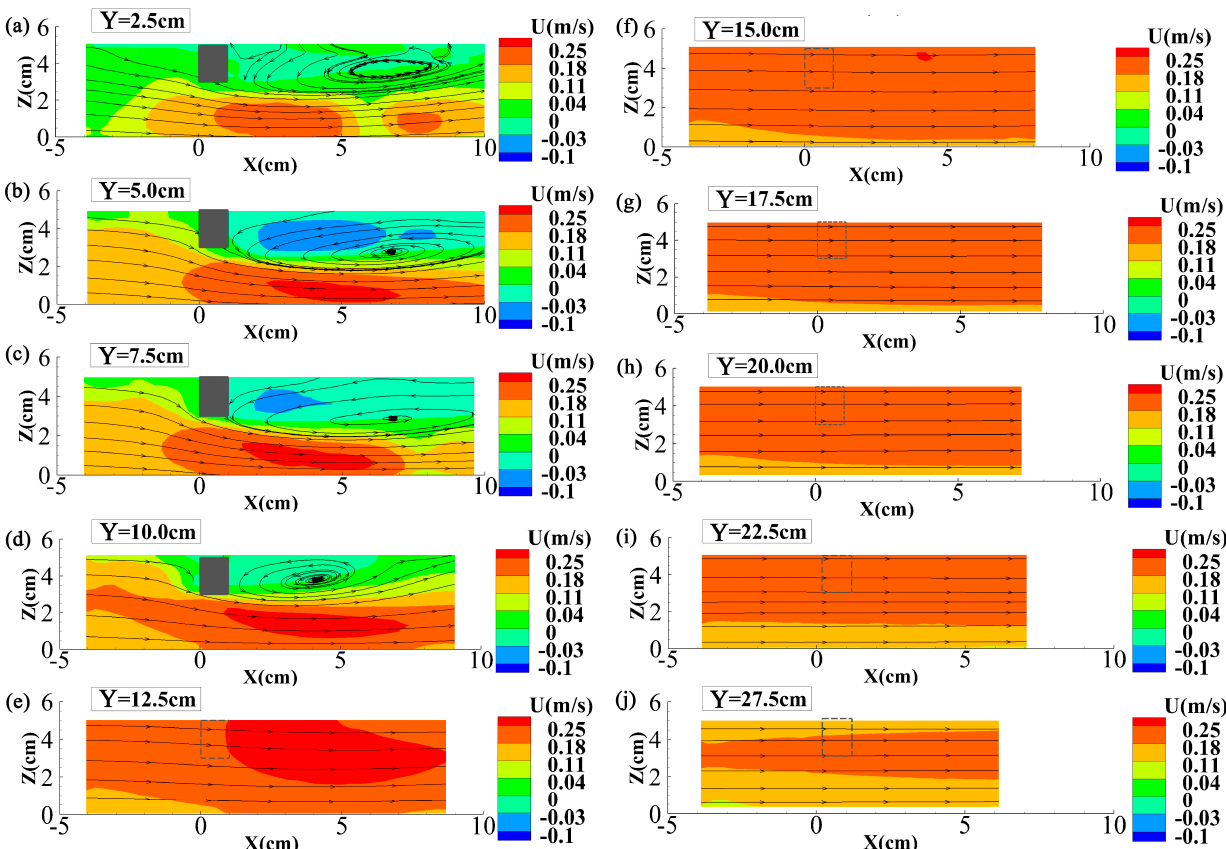
Figure 6. Distributions of the absolute velocity at longitudinal sections ( a ) Y = 2.5 cm, ( b ) Y = 5.0 cm, ( c ) Y = 7.5 cm, ( d ) Y = 10.0 cm, ( e ) Y = 12.5 cm, ( f ) Y = 15.0 cm, ( g ) Y = 17.5 cm, ( h ) Y = 20.0 cm, ( i ) Y = 22.5 cm, and ( j ) Y = 27.5 cm in Case 2. The grey areas in subfigures ( a ) to ( d ) demonstrate the floating dike, and the dotted lines in subfigures ( e ) to ( j ) indicate the location of floating dike in the coordinate system.